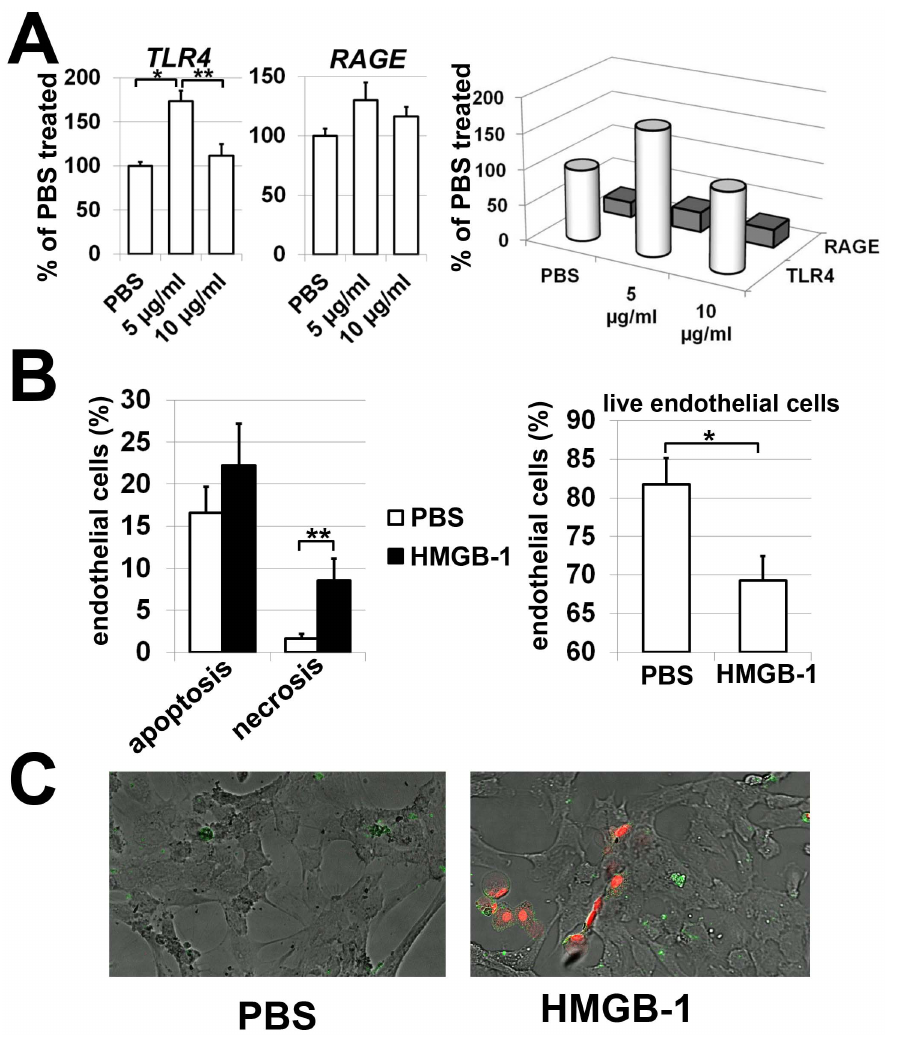
Figure 4. HMGB-1 directly mediates retinal endothelial cell death. ( A ) Expression of HMGB-1 receptors (TLR4 and RAGE) in HMGB-1-treated (5 and 10 m g/ml) and control (PBS-treated) retinal endothelial cells. ( B ) Treatment with HMGB-1 (10 m g/ml) increases cell death in primary human retinal endothelial cell cultures. All experiments were repeated at least three times (*P , 0.05, **P , 0.01). ( C ) Endothelial cell death was determined using annexin V and annexinV/PI to identify apoptotic and necrotic cells,